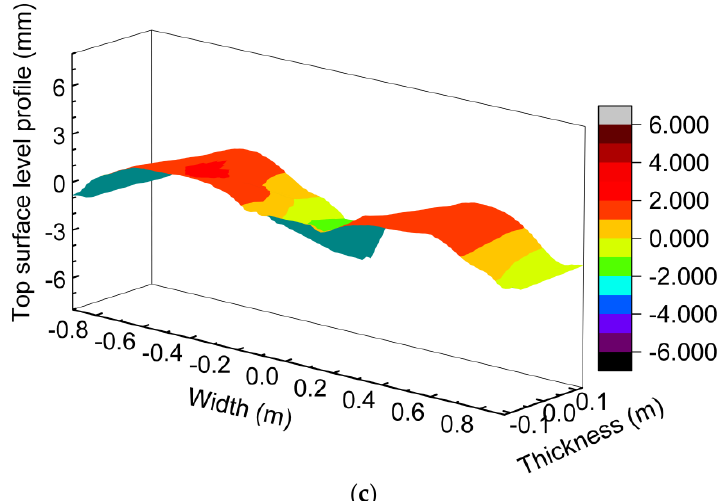
Figure 11. Top surface level profiles of mold at the different immersion depths of ( a ) 140 mm, ( b ) 160 mm, ( c ) 180 mm.